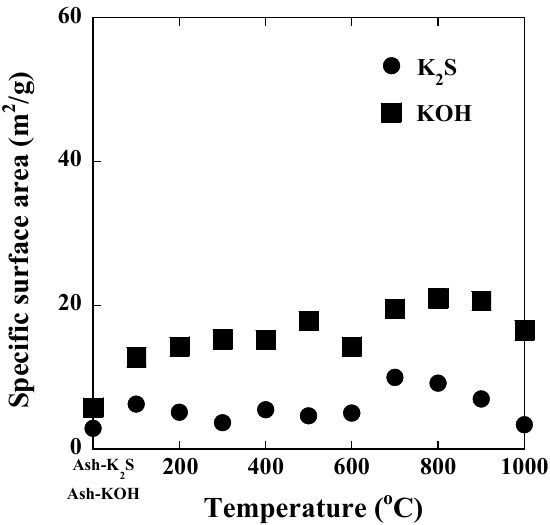
Figure 6. Specific surface areas of products pyrolyzed at various temperatures.